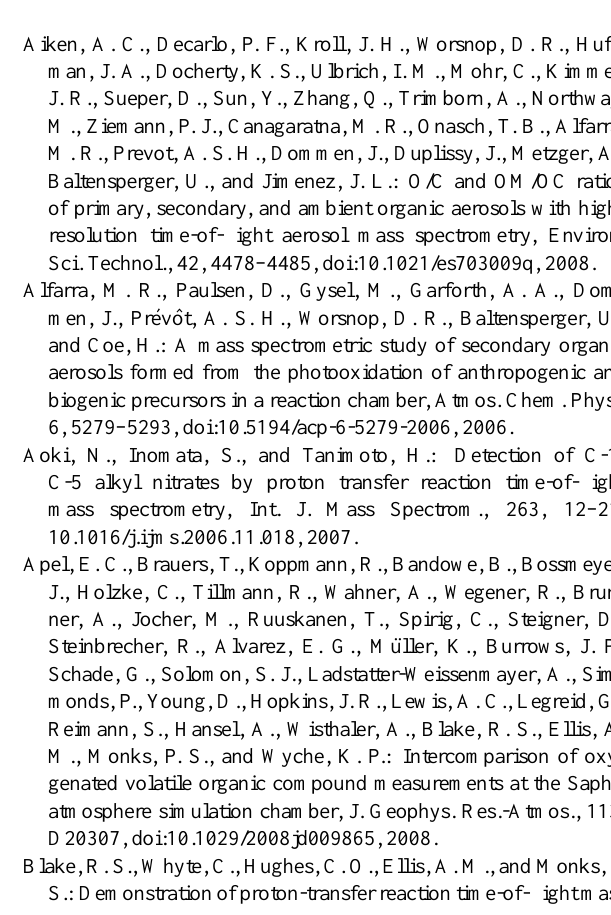
OS C . Observed OS C values in the range between of − 0 .